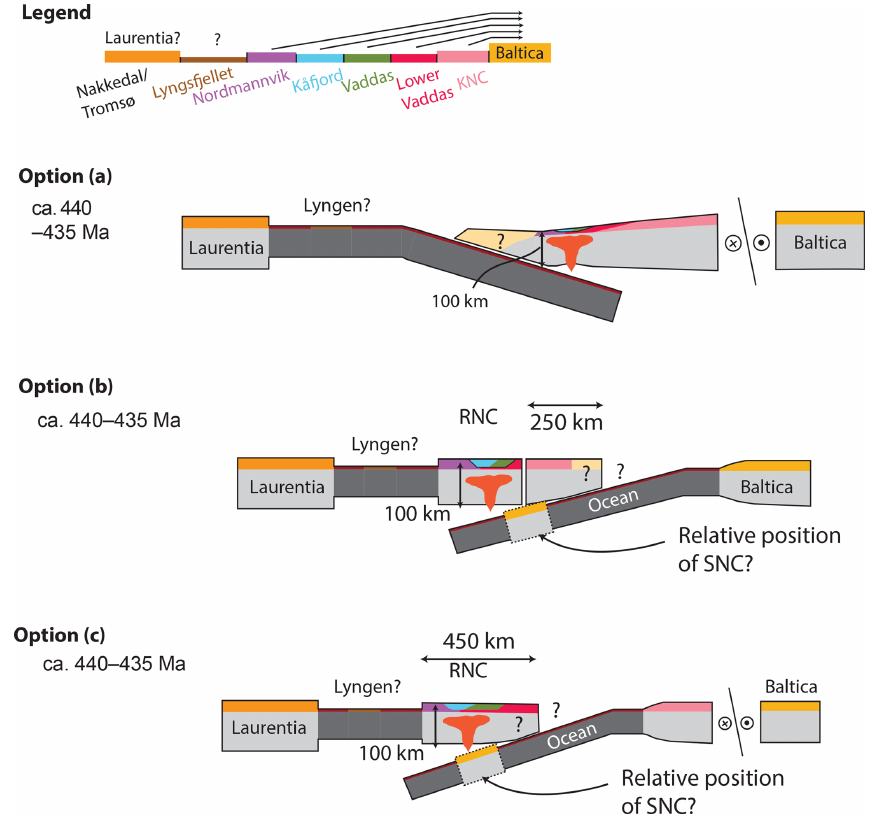
Figure 15. Diagram depicting some of the tectonic models discussed for the Caledonian nappes in the study area. The legend (top) shows the nappes in their relative palaeogeographic positions prior to D 2 nappe thrusting. Option (a) displays eastward-dipping subduction with the RNC as a back arc on an upper Baltica plate (e.g. Andréasson et al., 2003). Option (b) and (c) show westward-dipping subduction with the RNC in a back-arc position. Option (b) has the KNC on the upper plate, whereas option (c) has the KNC on the down-going